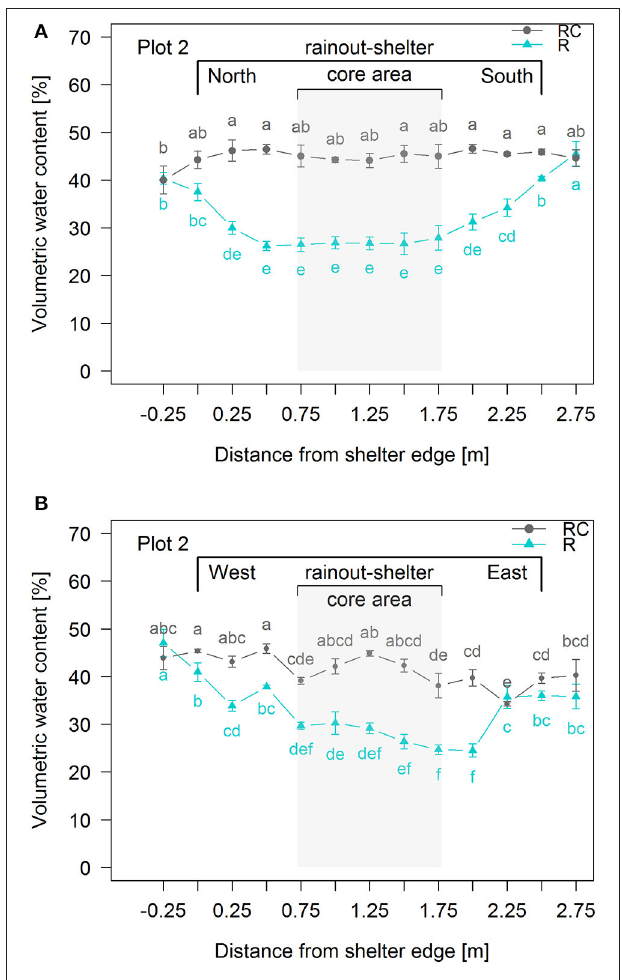
FIGURE 3 | (A) Assessment of the soil water content under the rainout-shelter (R) and the rainout-shelter control (RC) using a handheld TDR device (ML-2x ThetaProbe, Delta-T) in the top 6cm of soil. Data points represent means ± standard deviation, n = 3. We measured along transects located (A) North–South and (B) West-East in two of the eight experimental plots (Plot 2, see also Supplementary Figure 3) on May 15, 2017. Data was analyzed by a one-way ANOVA followed by a Tukey’s honestly significance post-hoc test. Means within treatments not sharing the same letter are significantly different (Tukey HSD, P < 0.05). Rainout-shelters were located with the lower side facing west as this is the prevailing wind direction at the study site.